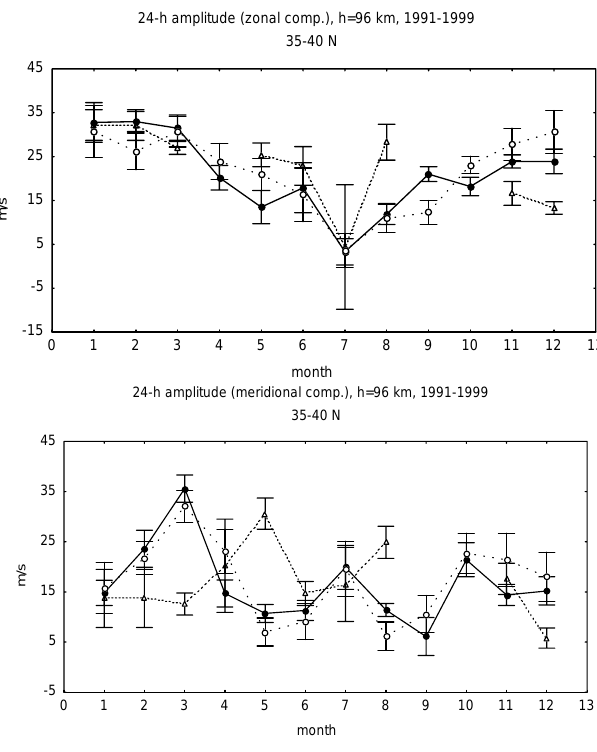
Fig. 2. Climatic season variations of the prevailing zonal (top) and meridional (bottom) wind components at 96 km during 1991–1999 as seen by HRDI and by the meteor radar at Shigaraki. Filled cir- cles: HRDI data for the 35 ◦ –40 ◦ N latitude belt, averaged over all longitudes. Open circles: HRDI data for the 91 ◦ –181 ◦ E longitude sector. Open triangles: Shigaraki data (35 ◦ N, 136 ◦ E). Vertical bars represent one standard deviation.